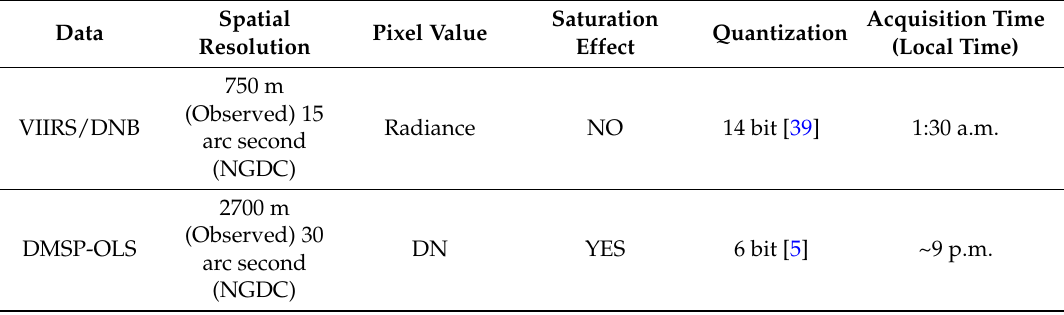
Table 8. Main differences between VIIRS-DNB and DMSP-OLS